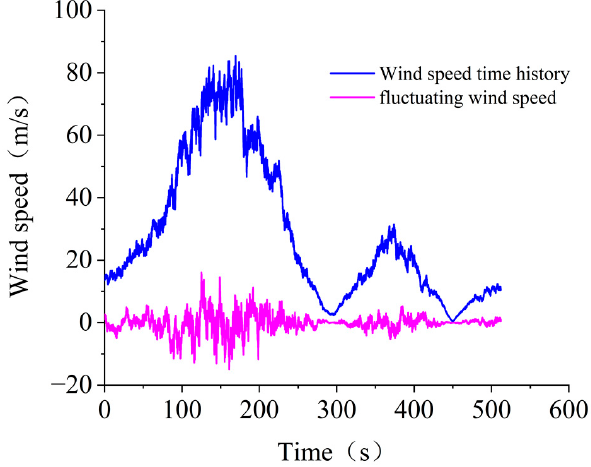
Figure 4. Downburst wind speed time history.